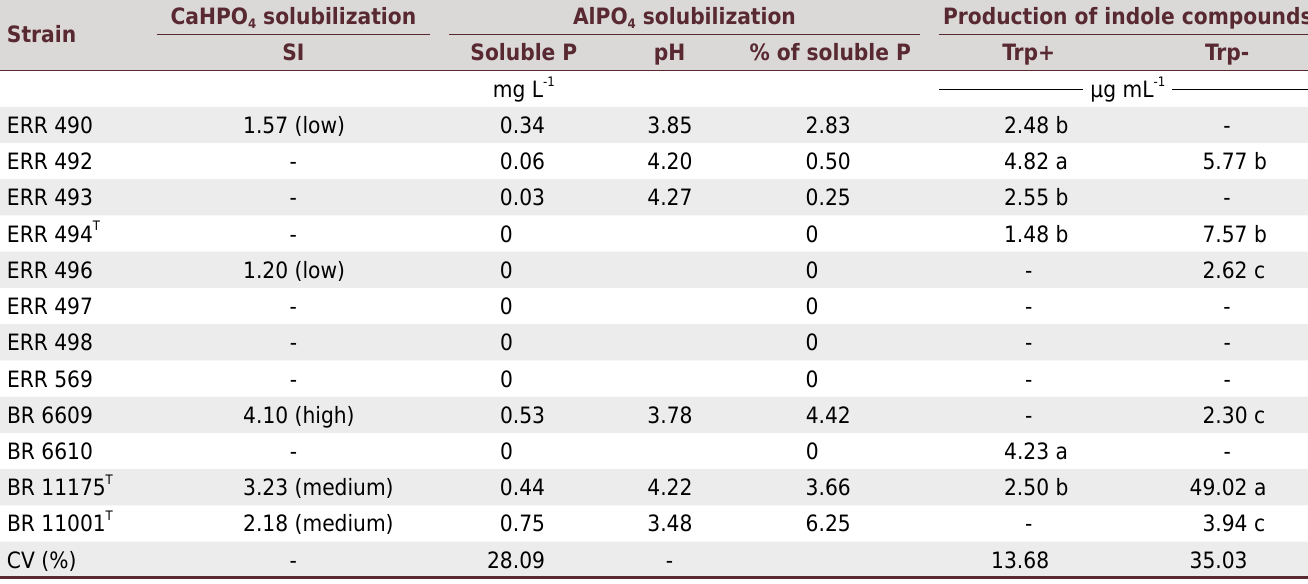
Table 5. Phosphate solubilization and production of indole compounds by Bradyrhizobium ingae strains CaHPO 4 Strain